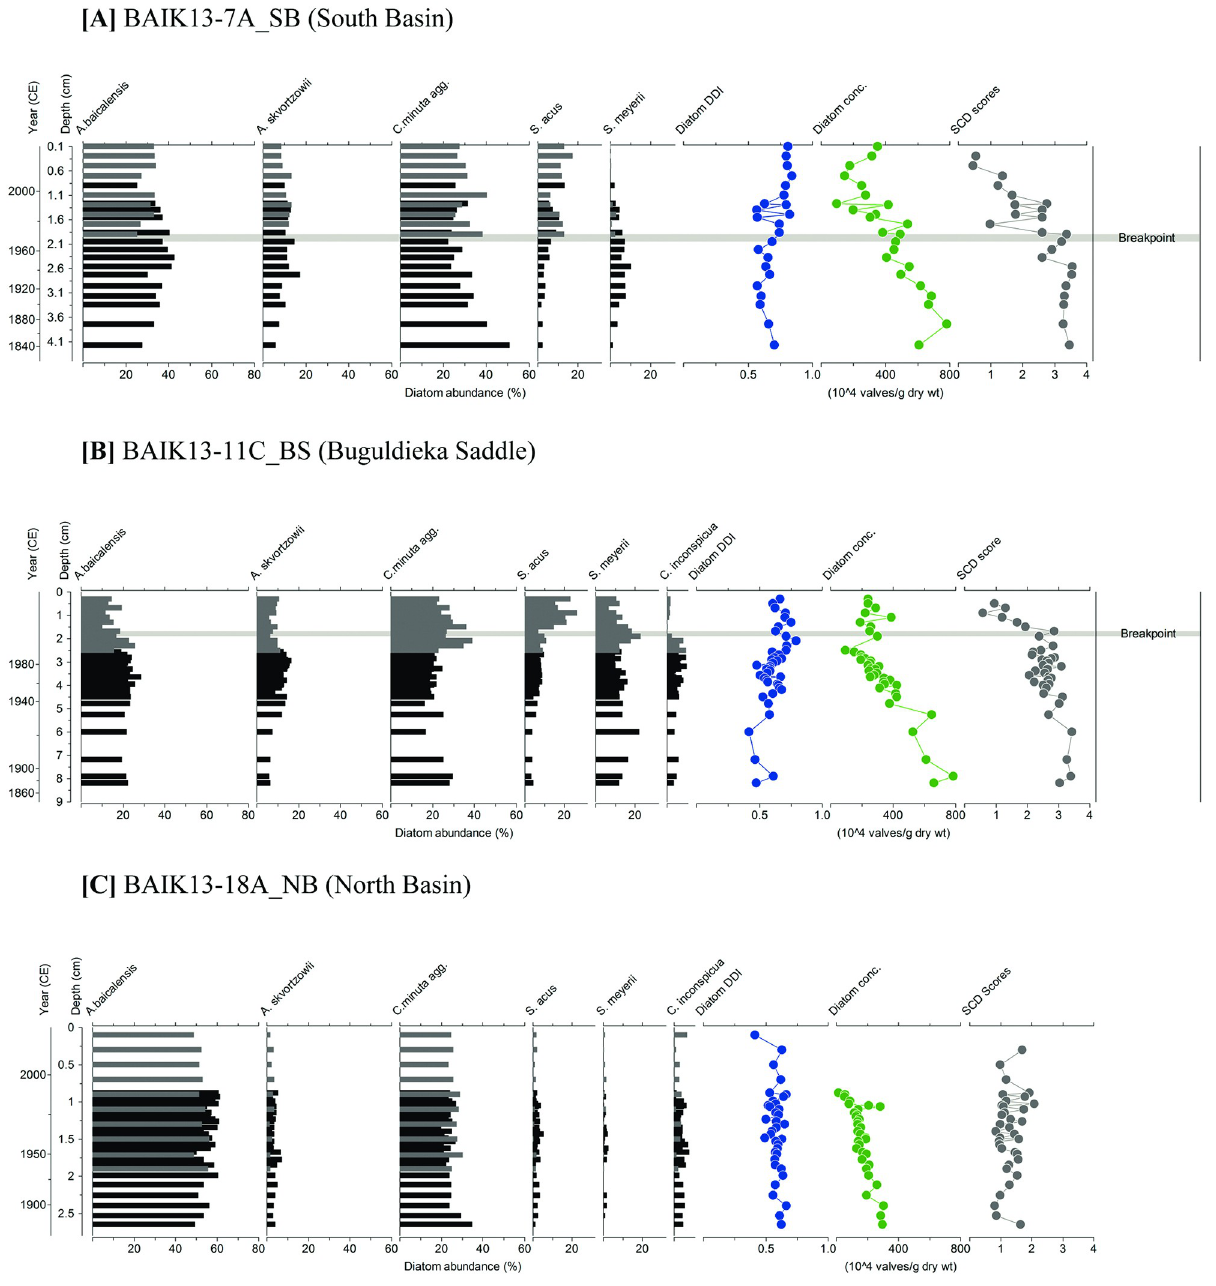
Fig 5. Stratigraphic plot of diatom assemblages at (A) BAIK13-7A_SB, (B) BAIK13-11C_BS, (C) BAIK13-18A_NB with core top samples (represented by grey bars) overlapping with diatoms records from [31] (A) BAIK38_SB, (B) BAIK19_BS, (C) BAIK29_NB (represented by black bars). Diatom Dissolution Index (DDI) and diatom concentrations (10 4 valves/g DW) are shown alongside diatom abundances (species with > 2% abundance). SCD dissimilarity scores are shown for the diatom dataset. The timings of significant breakpoints in the SCD scores are highlighted in grey for BAIK13-7A_SB and BAIK13-11C_BS diatom assemblages. No significant breakpoints were found in the BAIK13-18A_NB diatom assemblage data. [SB: South basin; BS: Buguldieka Saddle; NB: North basin].